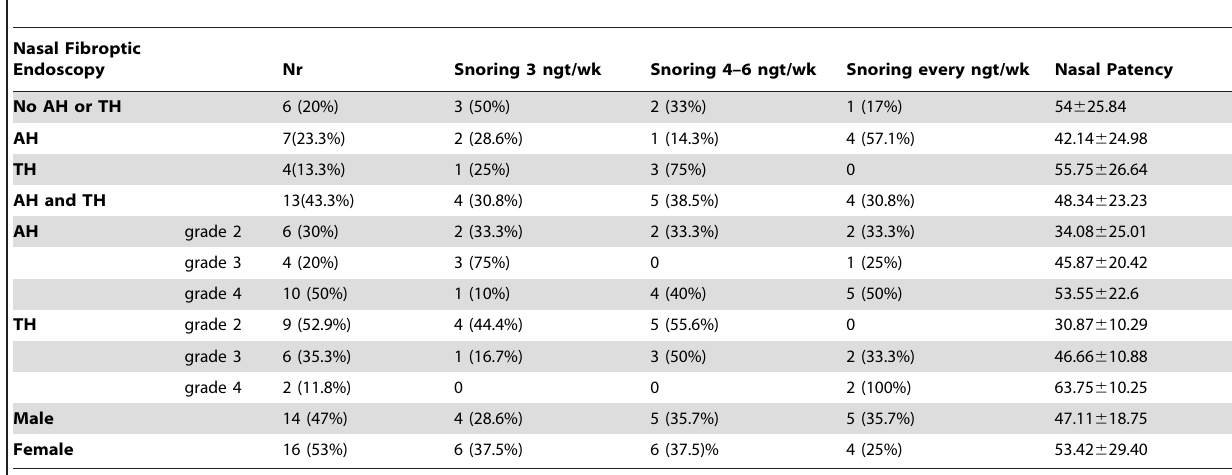
Table 1. Severity of snoring and nasal patency stratified according to sex, adenoid (AH), tonisllar (TH), adenoid plus tonsillar hypertrophy (AH and TH) and no adenoid or tonsillar (No AH or TH) hypertrophy.